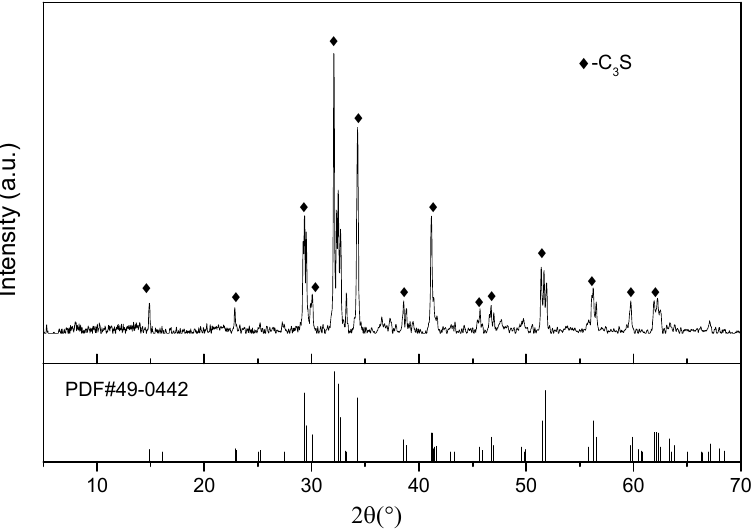
Figure 1. X-ray di ff raction (XRD) patterns of tricalcium silicate (C 3 Figure 1. X ‐ ray diffraction (XRD) patterns of tricalcium silicate (C 3 S).